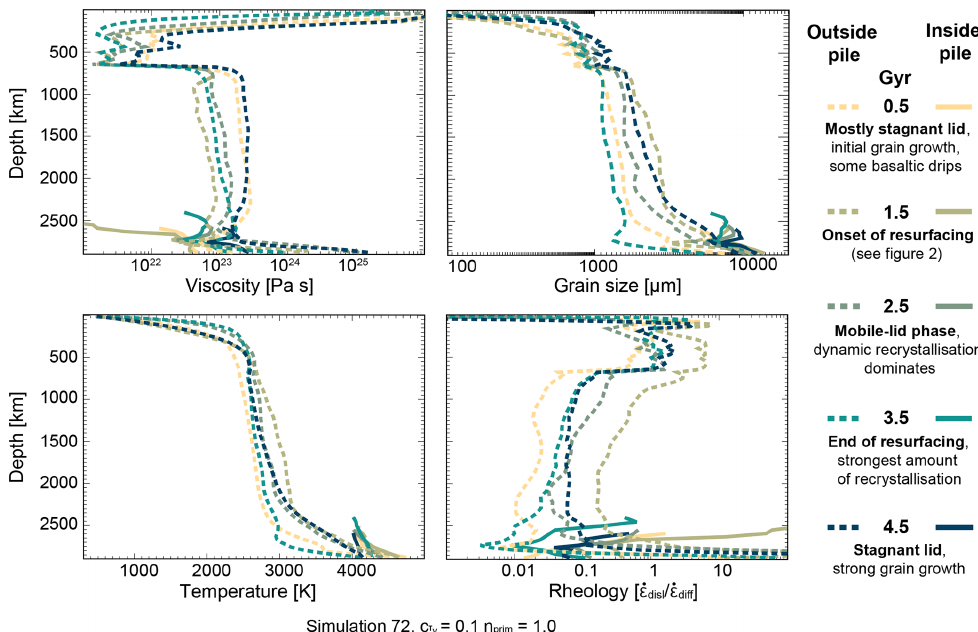
Figure 5. 1D profiles of grain size, viscosity, temperature and rheology through the whole model domain (model no. 72). The dashed lines show the average values of crust and ambient mantle for five time steps; the solid curves show average properties within the pile for the same time steps. Convection regime descriptions are provided in the